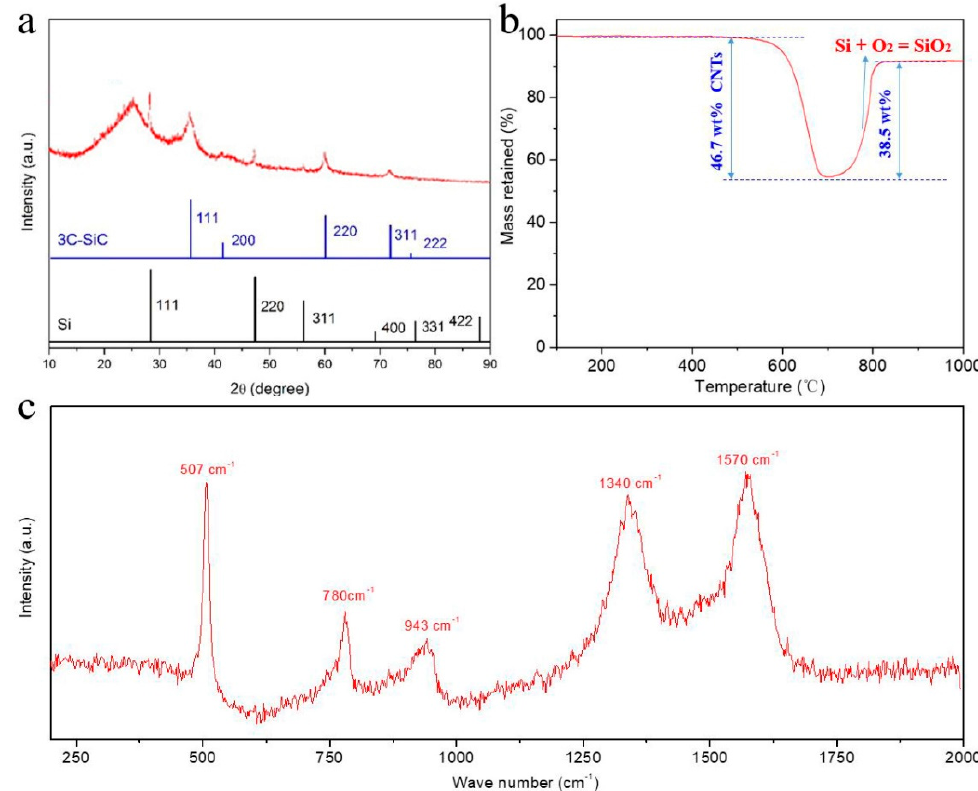
Figure 4. ( a ) XRD patterns of the Si/SiC/CNT nanocomposite; ( b ) TGA of Si/SiC/CNT nanocomposite; ( c ) Raman spectrum of Si/SiC/CNT nanocomposite.